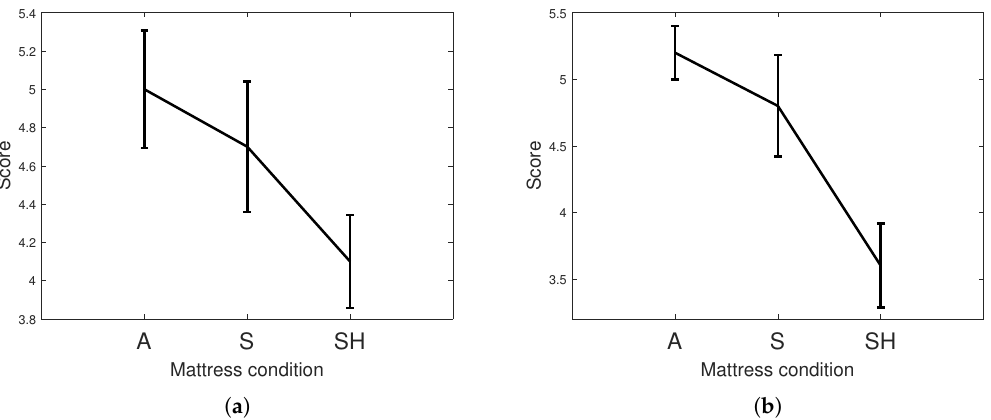
Figure 7. Mean and standard error of the subjective evaluations regarding the ( a ) depth and ( b ) length of sleep on different mattresses under different conditions obtained from the questionnaires to the